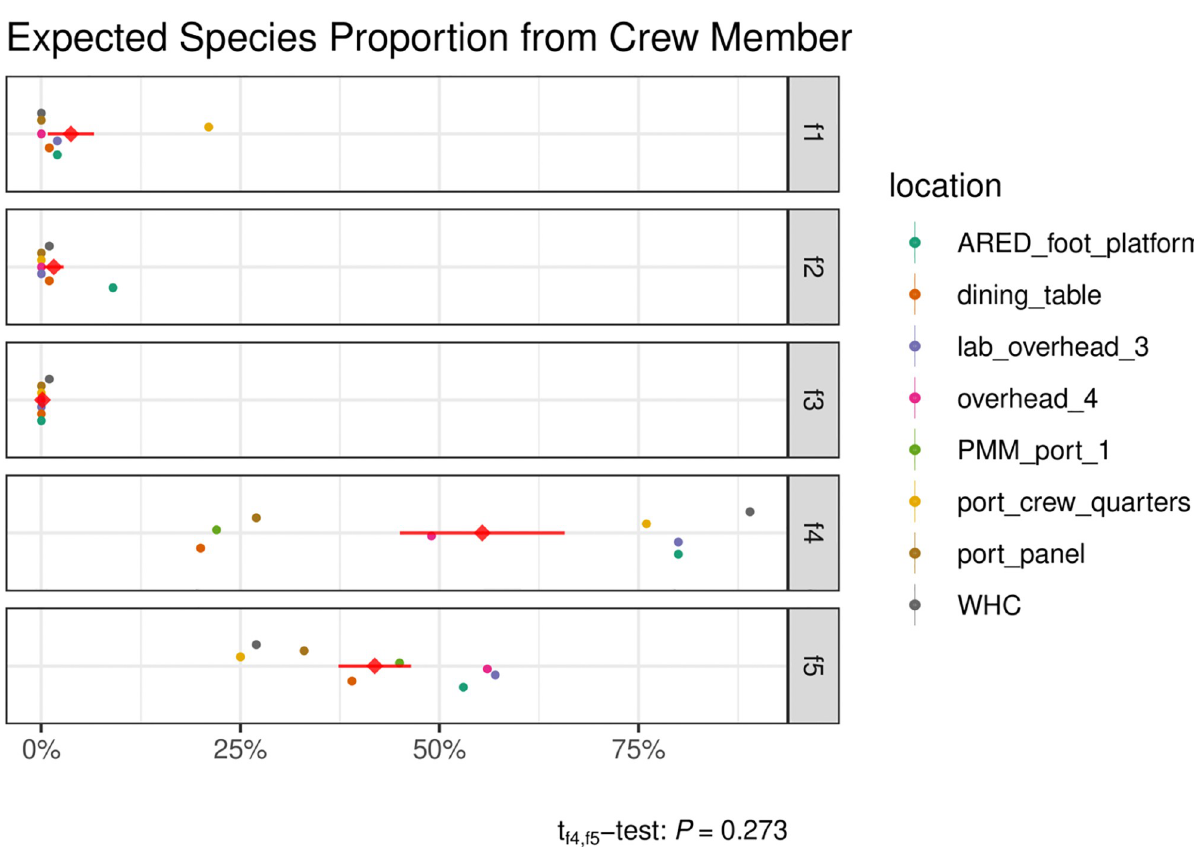
Fig 6. Assessment of astronaut contribution to the ISS microbiome. SourceTracker was used to assess the proportion of crewmember 1 microbiome sequences to Flight 4 and Flight 5 ISS surface microbiome sequences. This was done by comparing the species compositions of reads found in the crewmember inflight samples (“source”) with those of various flight samples (“sink”). The expected proportion of reads contributed by crewmember 1 for each sink (i.e., surface location, by flight) is shown along the x-axis. The standard deviation of the predicted proportions for each sink was either 0.00 or 0.01, computed from 10 Gibbs samples per sink location, and thus treated as point estimates. The mean contribution per flight across surface locations (diamond) and its standard error are shown in red.